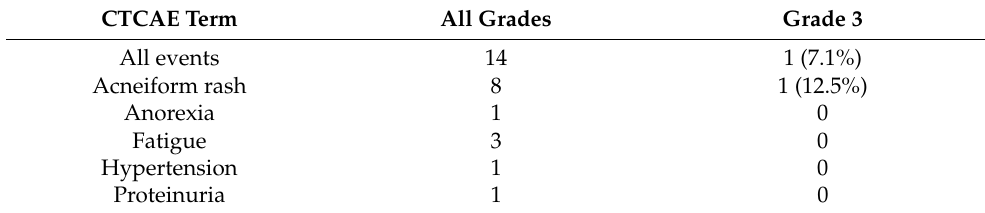
Figure 3. ( A ) Progression-free survival and ( B ) overall survival from treatment initiation with bevacizumab plus erlotinib. The shaded areas represent the 95% confidence bands for each curve. CI, Confidence interval. Table 3. Treatment-related adverse